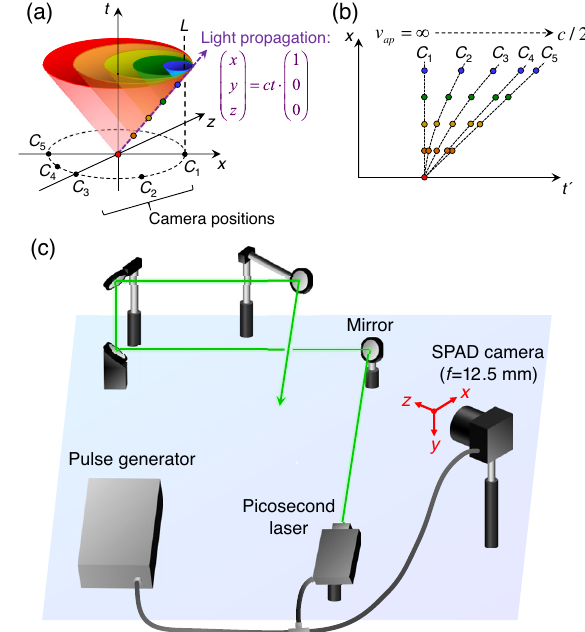
FIG. 1. Principle and experimental setup for four-dimensional light-in-flight imaging. (a) Schematic illustration of light propa- gation and scattering in Minkowski space at y ¼ 0 . Propagating light is depicted as a purple dashed arrow, and scattered light is shown as a light cone. (b) Schematic plot of t 0 dependence of x . The slope of the dashed line indicates the apparent velocity. (c) Experimental setup for light-in-flight imaging. The pico- second laser and SPAD camera are both controlled by a pulse generator. When performing the light-in-flight measurements, all the mirrors are confined by a large transparent acrylic box (not shown), and a fog generator forms a small amount of mist in the box to enhance the scattering of the laser in air. The origin of the Cartesian coordinate is set at the optical center of the lens of the SPAD